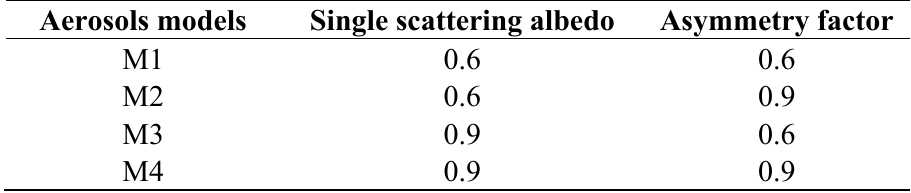
Table 2. Single scattering albedos and asymmetry factors of the 4 aerosols models used for the comparison between AMARTIS v2 and